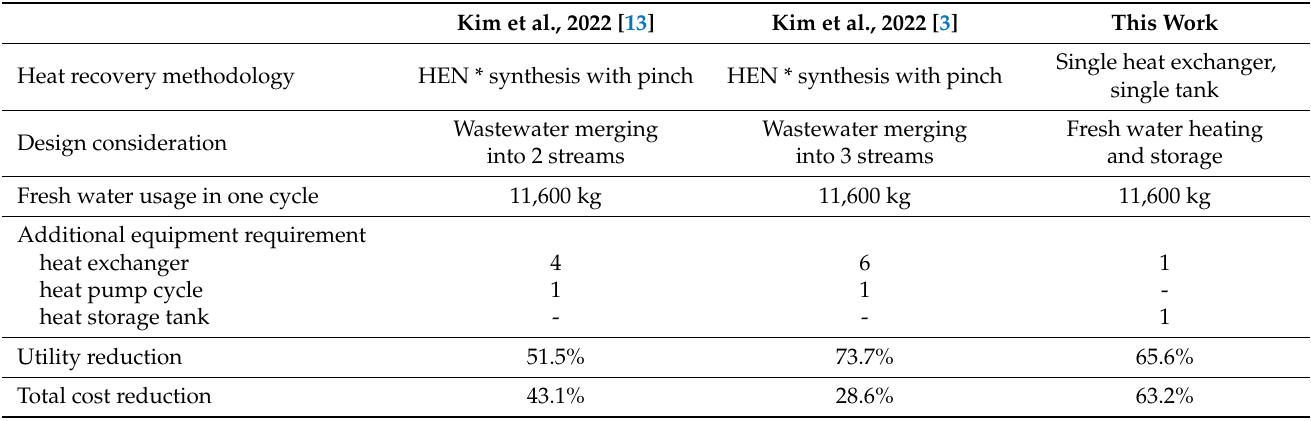
Table 12. Performance comparison among various heat recovery systems on the dyeing process. Kim et al., 2022 [13] Kim et al., 2022